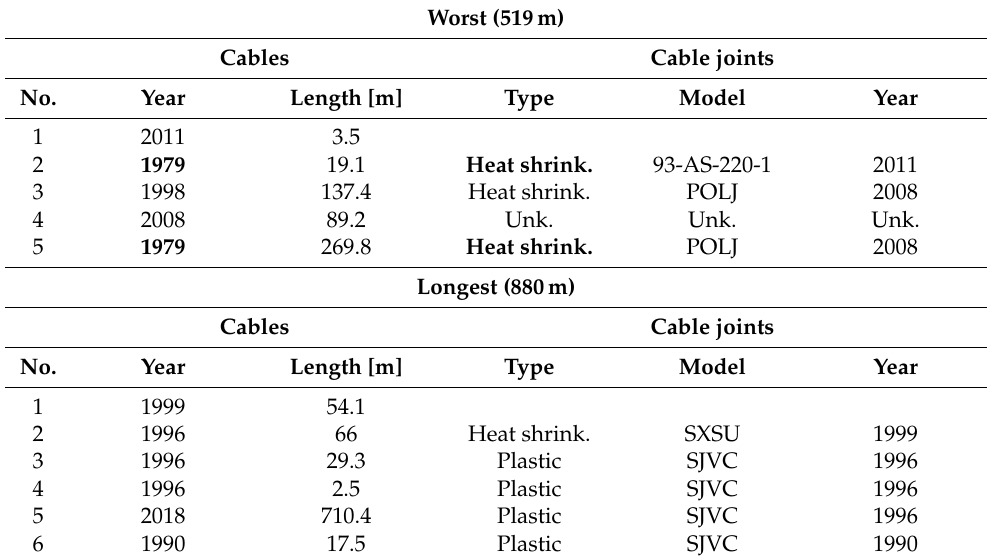
Table 4. Comparison of the worst and the longest measured